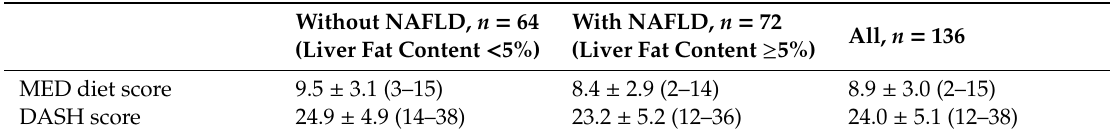
Table 3. Average diet quality scores of study participants with and without NAFLD.